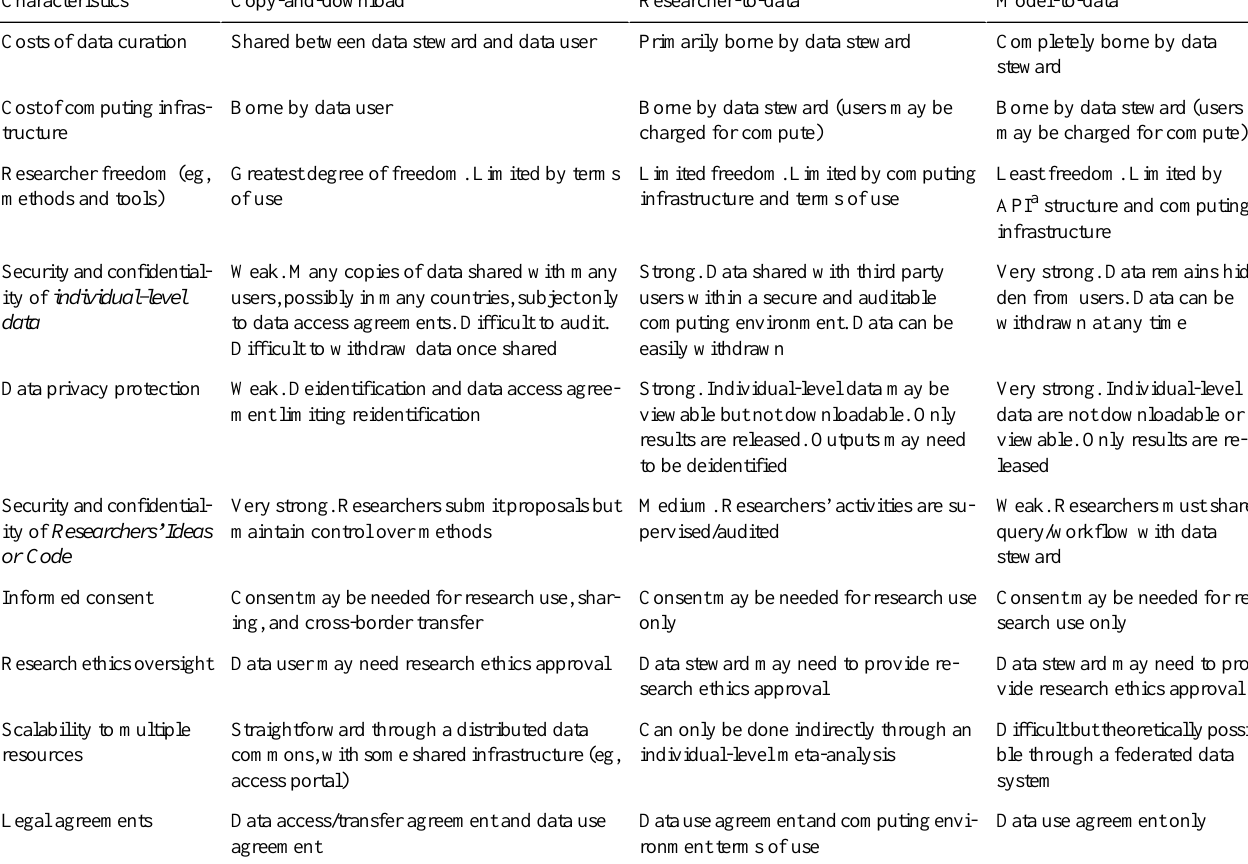
Table 1. Comparison of technical data access models.